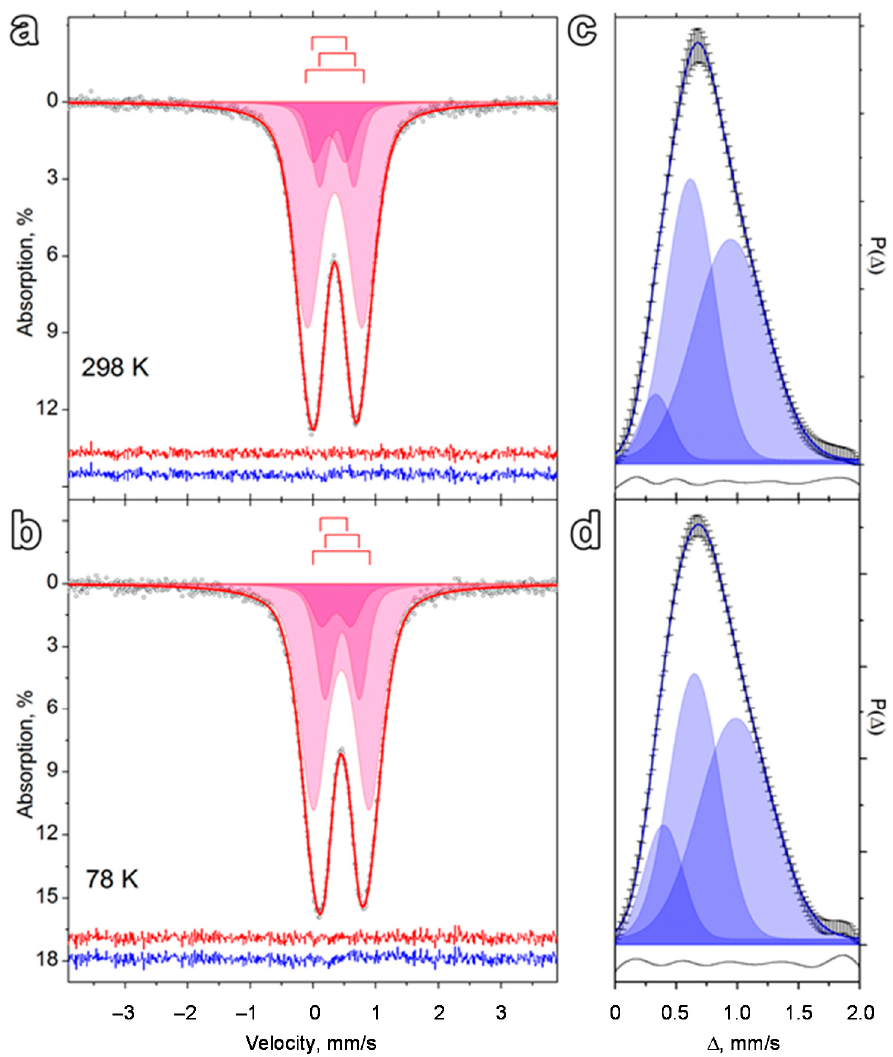
Figure 2. Mössbauer spectra at different temperatures of the ferrihydrite (FH) sample without urea treatment, models for their description ( a , b ), and the corresponding quadrupole splitting probability distribution functions ( c , d ). Table 1. The Mössbauer spectroscopy data for the ferrihydrite (FH) nanoparticles in the absence and presence of urea recorded at 298 K and 78 K.